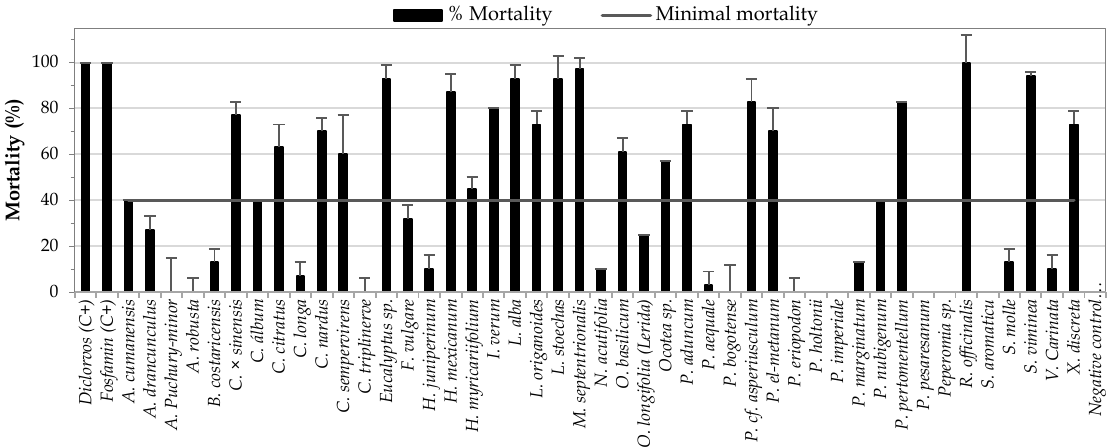
Figure 2. Screening of insecticidal activity for 45 EOs, evaluated at a concentration of 500 µL/L air, against S. zeamais.